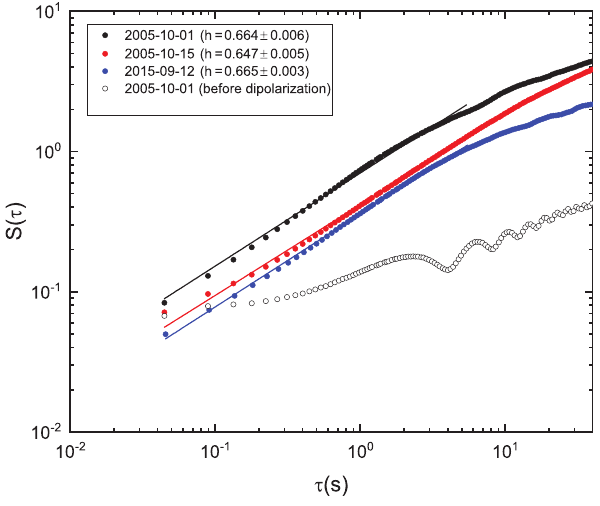
Figure 8. The example of Hölder